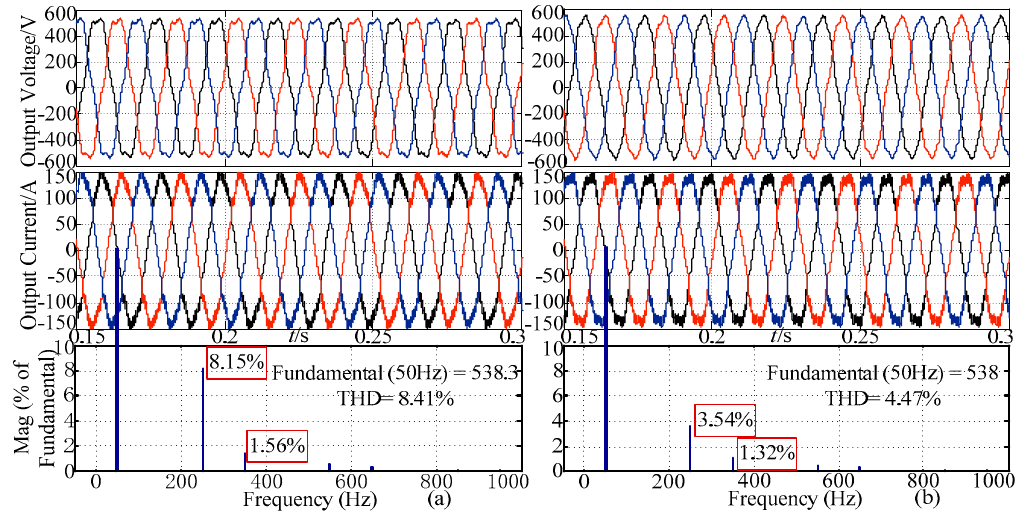
Figure 14. Simulation waveform with non-linear load. ( a ) Without resonant controller; ( b ) With resonant controller.